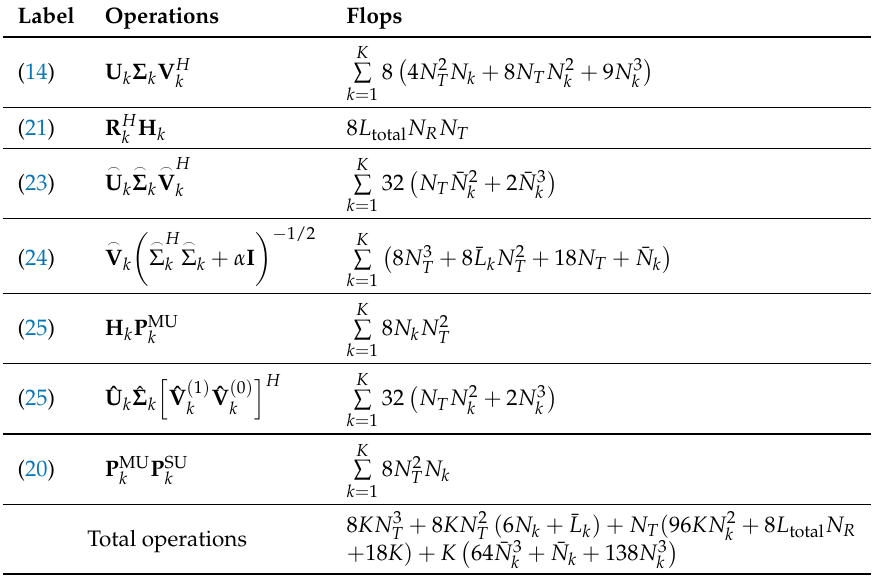
Table 3. Computational complexity of each operation for modified generalized block diagonalization (MGBD) at transmitter.